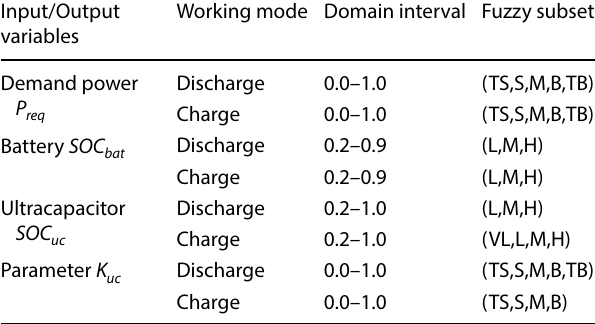
Table 3 Fuzzy domain and fuzzy subset of variables Input/Output